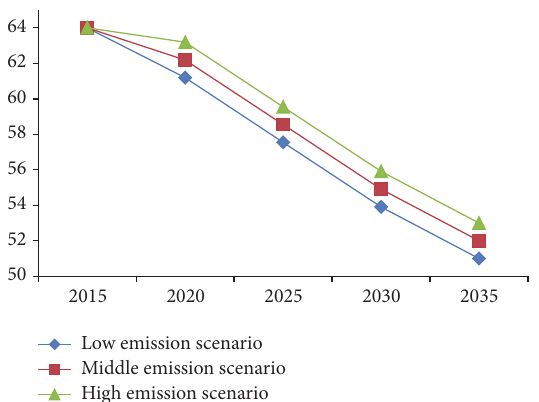
Figure 14: The trends of change of China’s carbon emissions from 2015 to 2035 (a hundred million